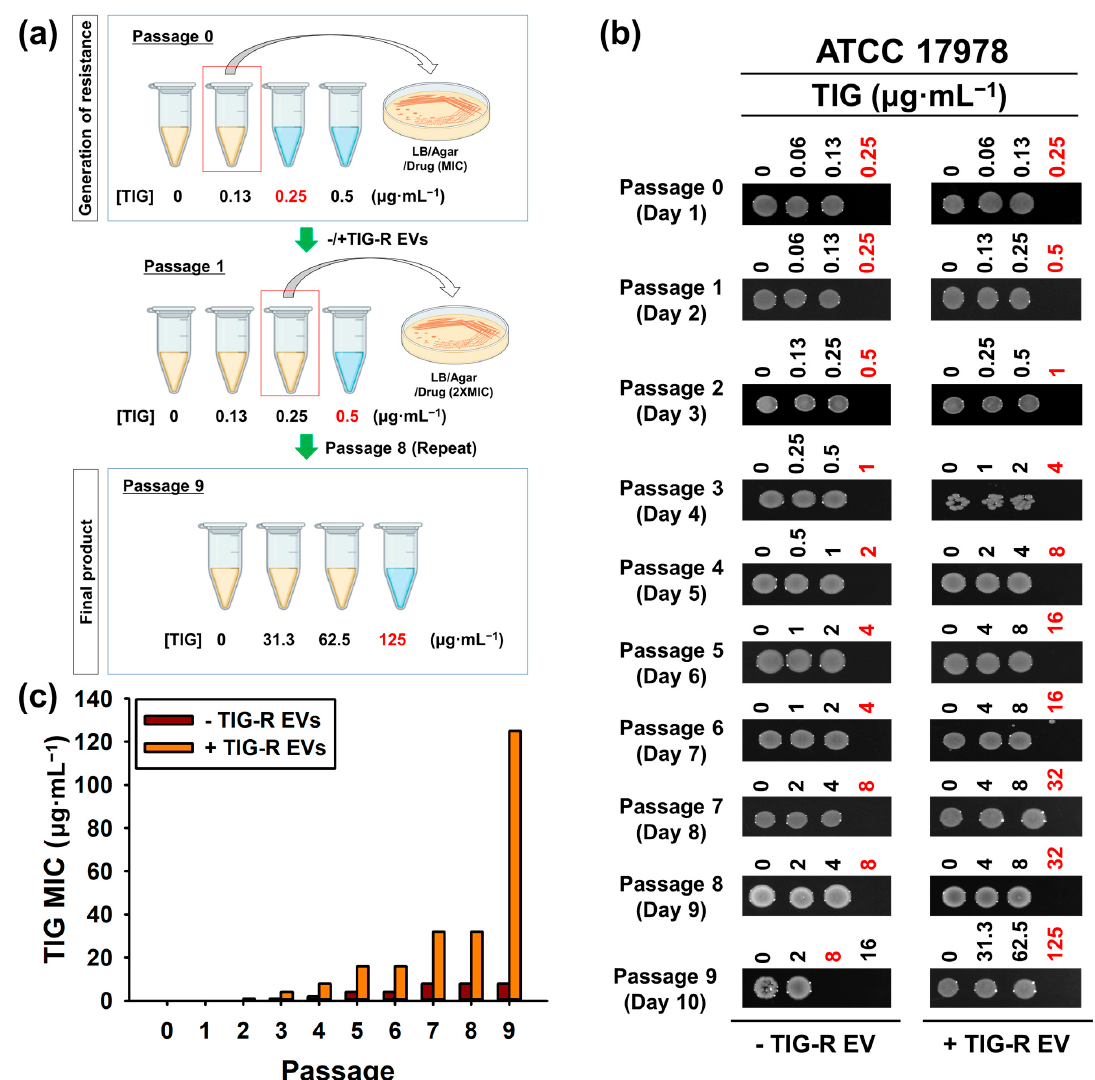
Figure 4. Evaluation of recurrence by TIG and TIG-R EVs. ( a ) Schematic representation of resistance generation method. ( b ) Determination of MIC values. Aliquots (5 µL) from cells at different concentrations of TIG from each passage were spotted onto LB-agar plates and were grown for 16 h. LB-agar plates were imaged and further processed by ChemiDoc TM MP Imaging System (Bio-Rad, Hercules, CA, USA) and Image Lab Software (ver.5.2.1, Bio-Rad, Hercules, CA, USA). One representative from n = 3 was shown. Red indicates MIC values for individual passage cells. ( c ) Comparison of TIG MIC between cells from ( b ).